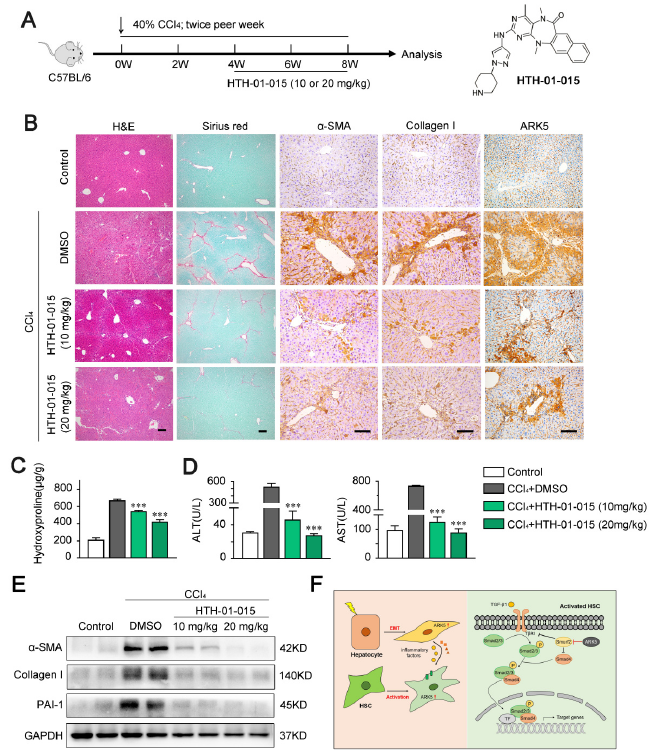
Figure 8. HTH-01-015 alleviates liver fibrosis in a CCl 4 -induced mouse model. ( A ) Schematic of the experimental design of HTH-01-015 (10 or 20 mg/kg) treatment in a CCl 4 -induced liver fibrosis mouse model. ( B ) Representative images of mouse livers stained with H&E, Sirius red, α -SMA, Col- lagen I and ARK5. Scale bars, 50 μ m. ( C ) Hydroxyproline content in liver tissues of indicated groups. ( D ) Levels of ALT, AST in serum from mice. ( E ) Western blot analysis showing α -SMA, Collagen I and PAI-1 protein levels of mouse liver tissues in indicated groups. ( F ) Schematic of ARK5 promot- ing liver fibrosis. Mean ± SD ( n = 3 per group). *** p < 0.001 versus CCl 4 + DMSO group. DMSO, dimethyl sulfoxide; ALT, alanine aminotransferase; AST, aspartate aminotransferase.